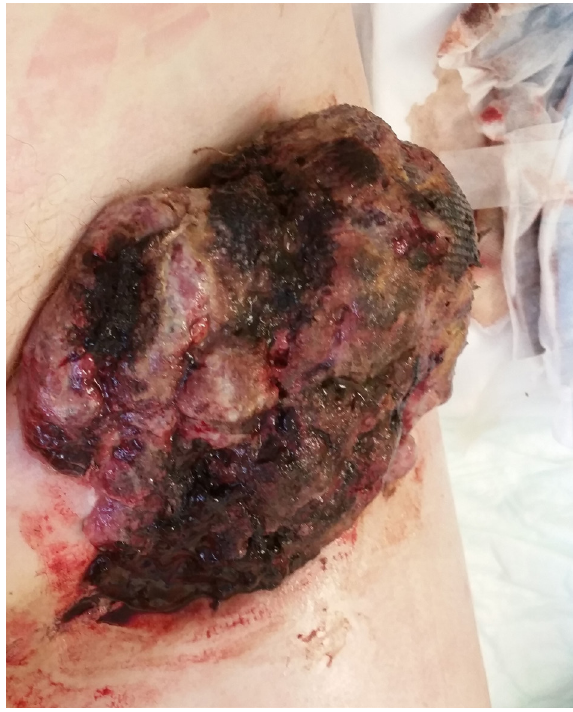
Figure 1: Ulcerated metastasis in the left groin at the start of the